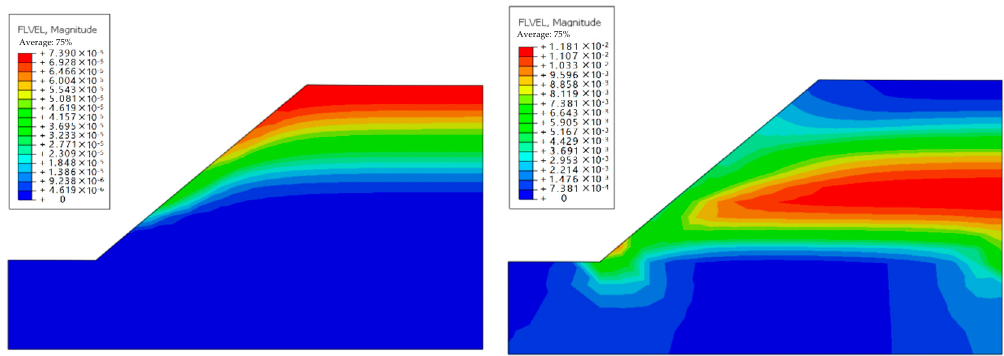
Figure 8. Internal flow velocity of slope at the beginning and end of rainfall.